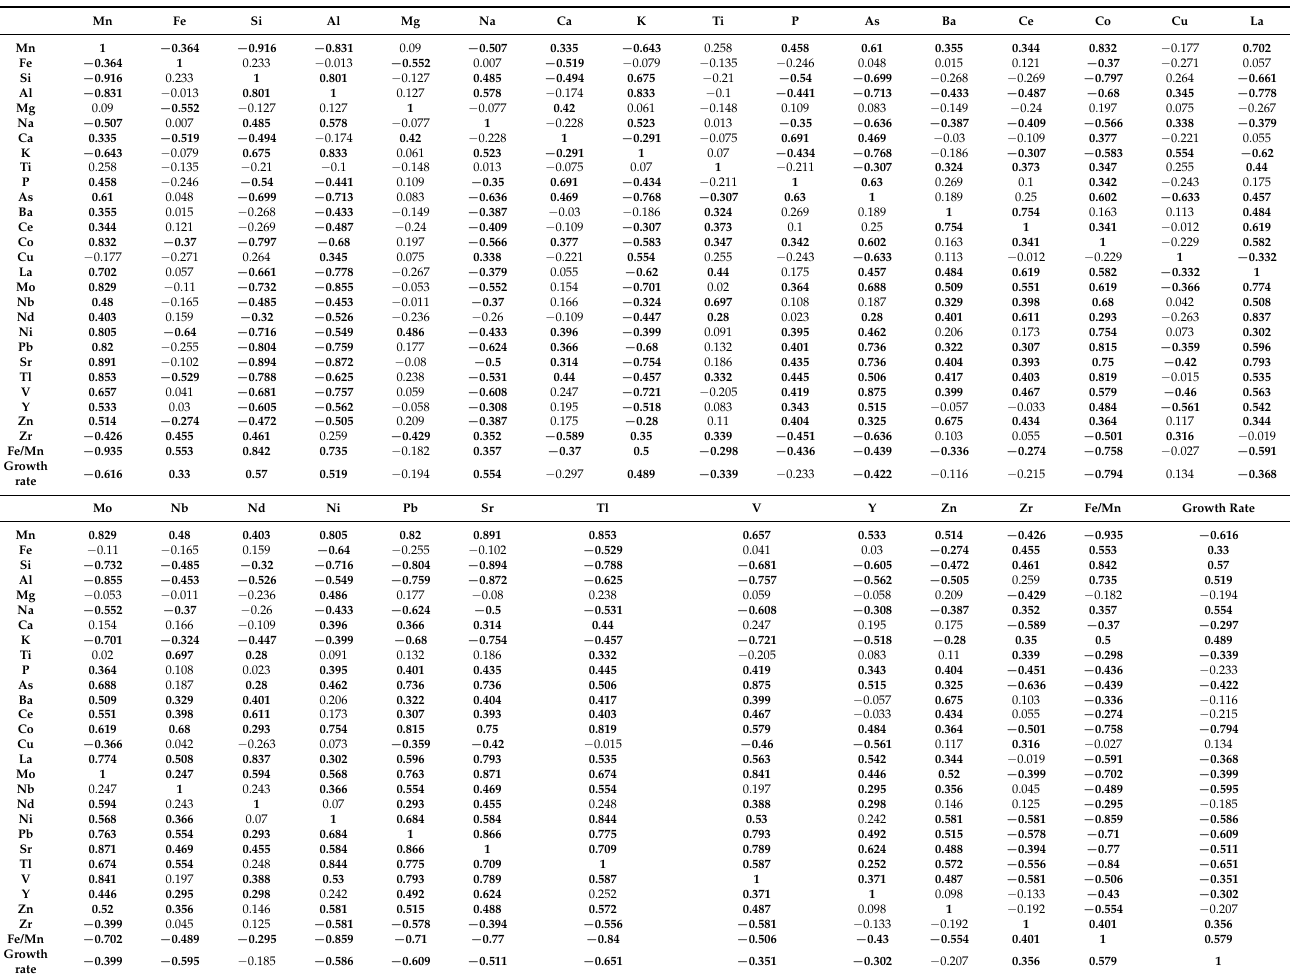
Table 5. Pearson correlation coefficients matrix for the hydrogenetic macro-layers and bulk crusts ( n = 89) a